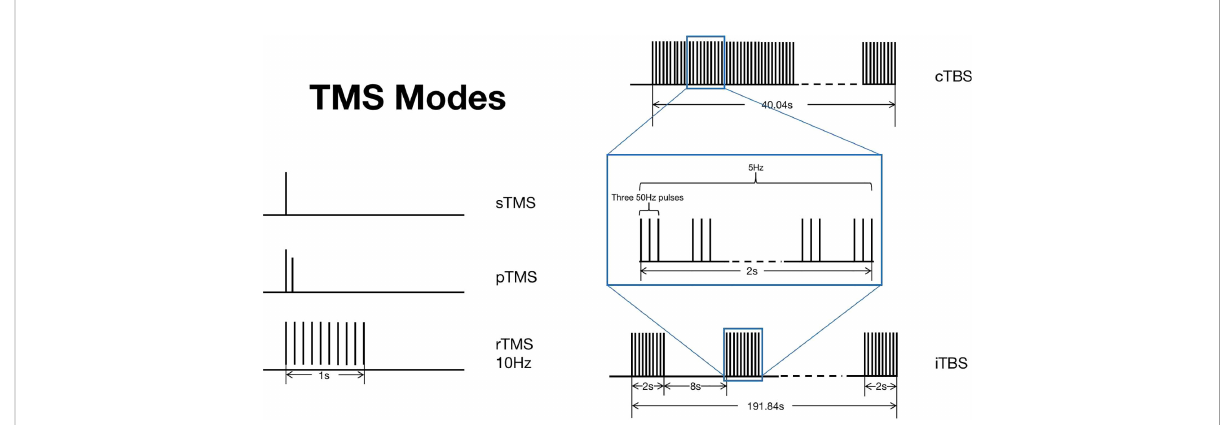
FIGURE 2 Transcranial magnetic stimulation (TMS) modes. TMS mainly has three stimulation modes, namely sTMS, pTMS, and rTMS. TBS is a new pattern of rTMS, which can be divided into two types: cTBS and iTBS. This fi gure shows the different stimulation patterns of TMS.